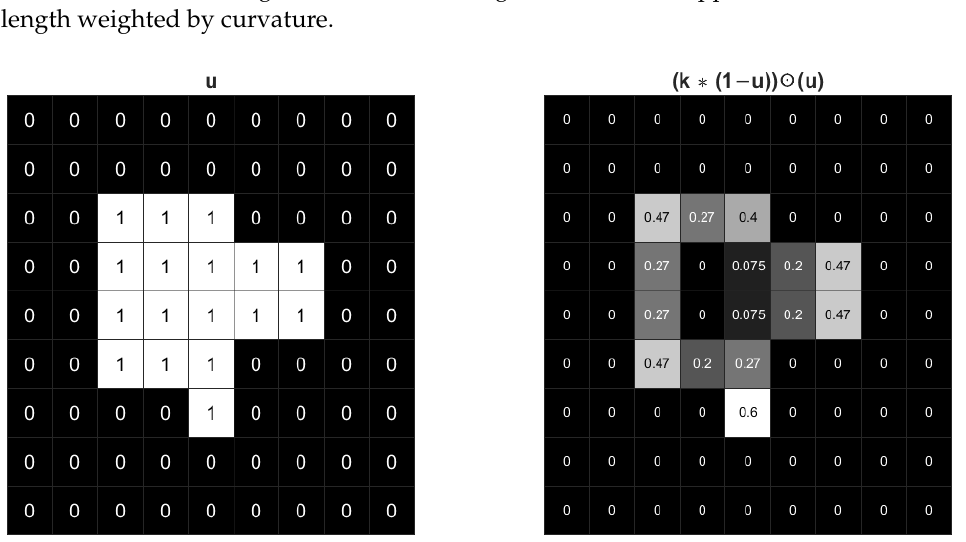
Figure 1. The effect of a 3 × 3 Gaussian kernel with σ = 1 for an image. The gray value shades correspond to the values of each